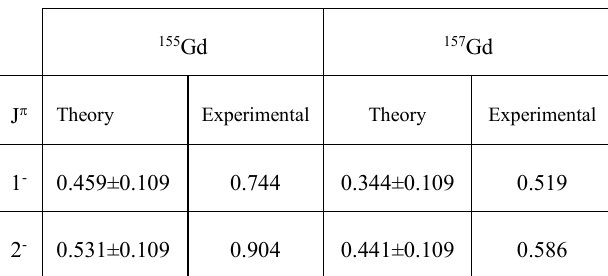
Table 5. Δ3-statistics